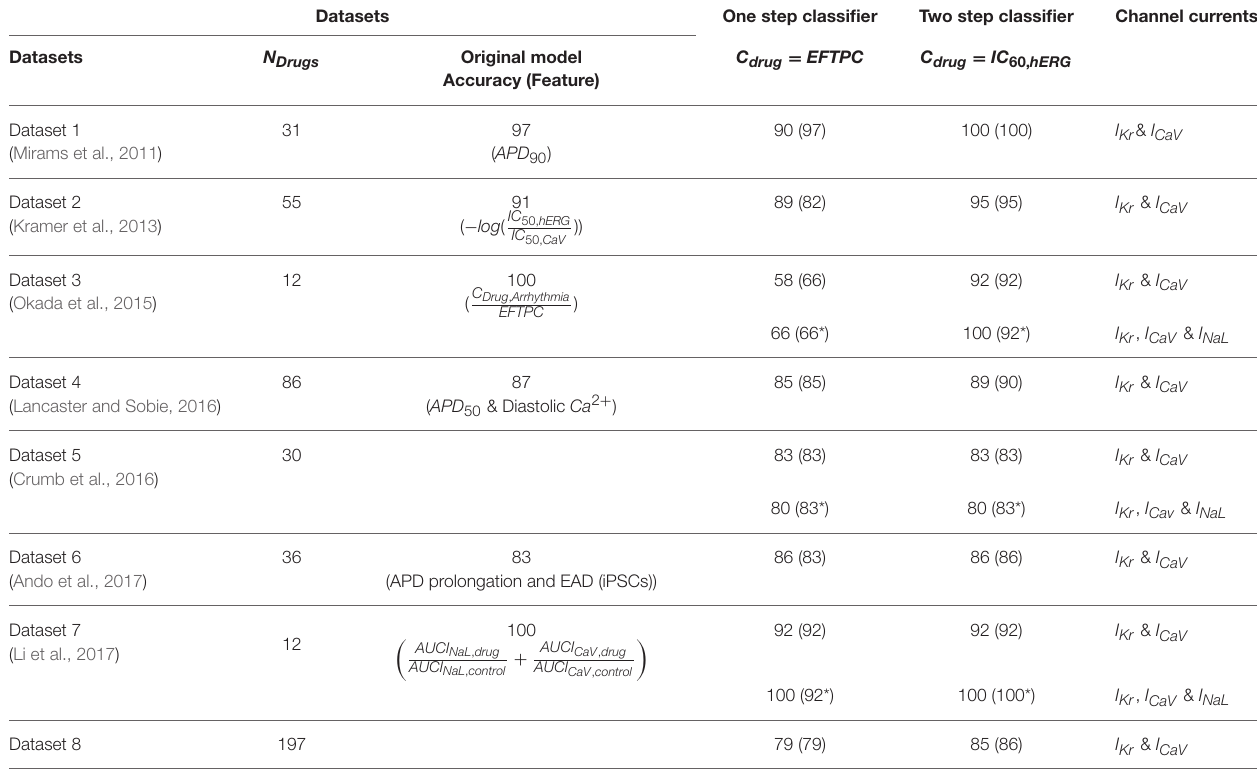
TABLE 4 | Binary TdP classifier scores of one-step and two-step classification on the direct features for the eight